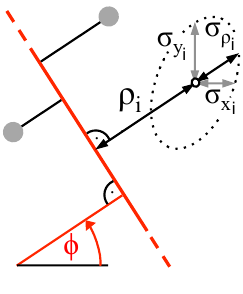
Figure 2. Optimum setting of weighting parameter for each data